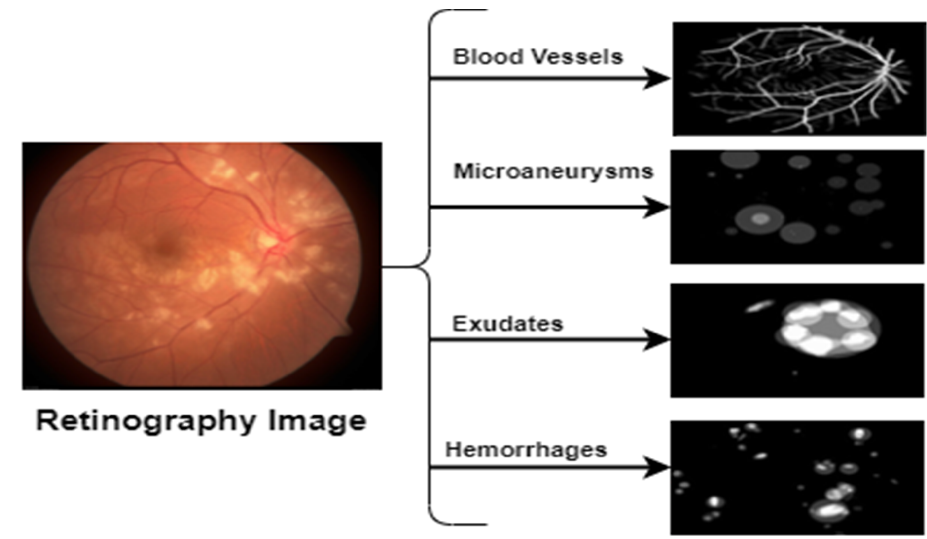
Figure 4. An HR fundus image used for the Mobile-HR system’s training.